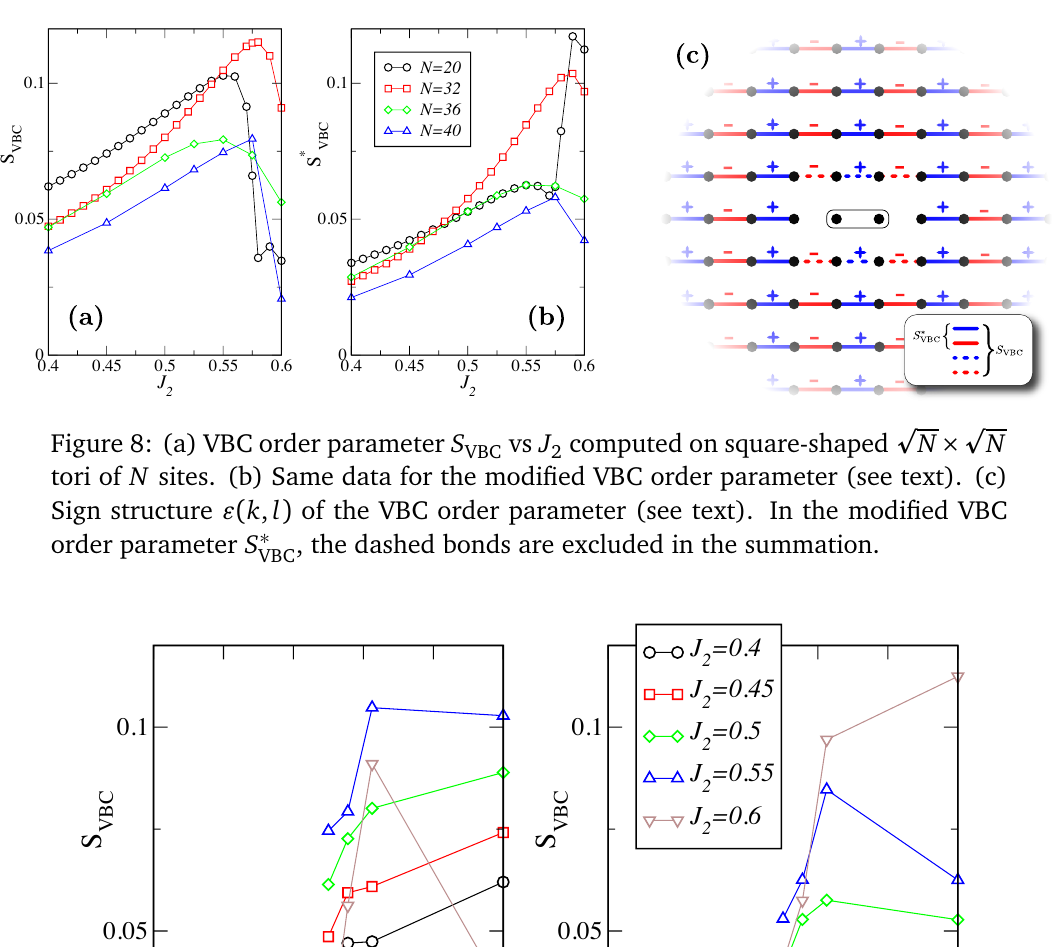
vs 1 / N . (b) Same data VBC (see VBC